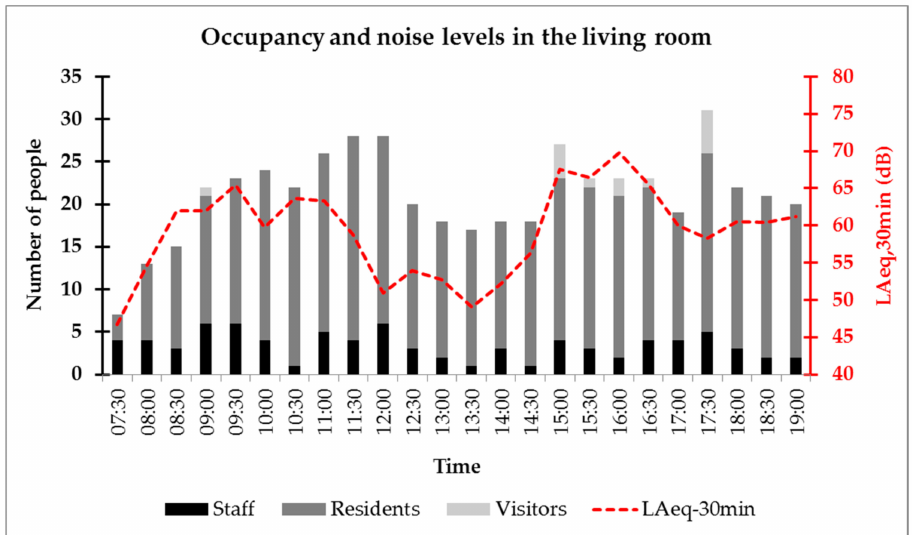
Figure 2. Occupancy levels stratified by user types and A-weighted equivalent sound levels as a function of time during the monitoring day in the living rooms.